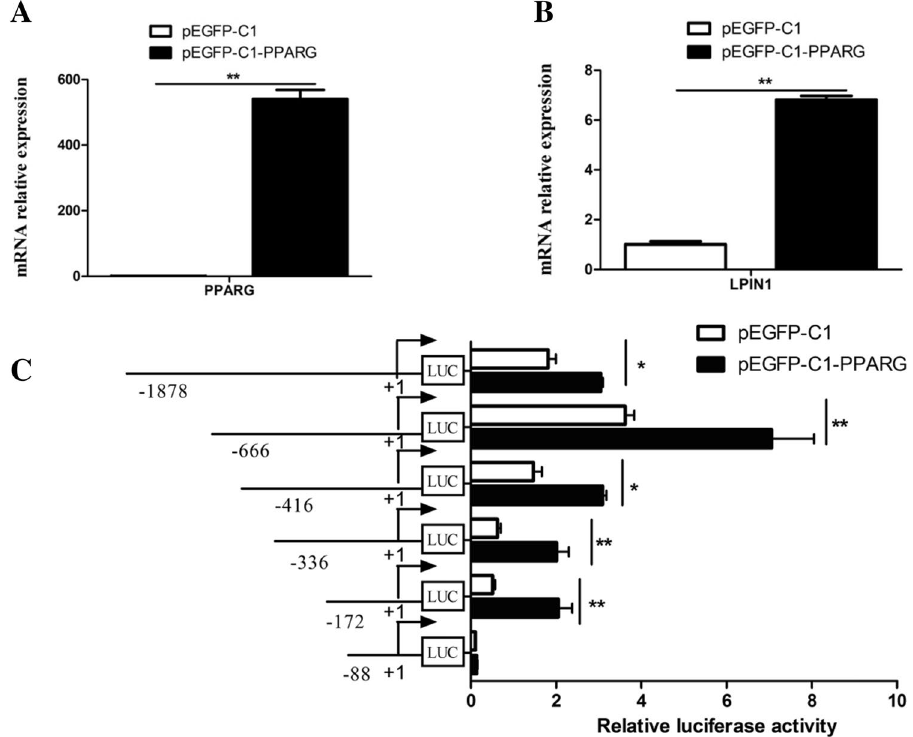
Figure 6. The effects of PPARG overexpression on the LPIN1 mRNA expression and promoter activity in the BMECs. ( A ) The mRNA expression of PPARG after transfection with pEGFP-C1-PPARG; ( B ) The mRNA expression of LPIN1 after transfection with pEGFP-C1-PPARG; ( C ) Relative luciferase activity (Firefly: Renilla) after 48 h transfection of pEGFP-C1-PPARG and different 5’ flanking deletion constructs (− 1878 bp/ + 42 bp, − 666/ + 42 bp, − 416/ + 42 bp, − 336/ + 42 bp, − 172/ + 42 bp and − 88/ + 42 bp. Values are provided as mean ± SEM; * P < 0.05; ** P <